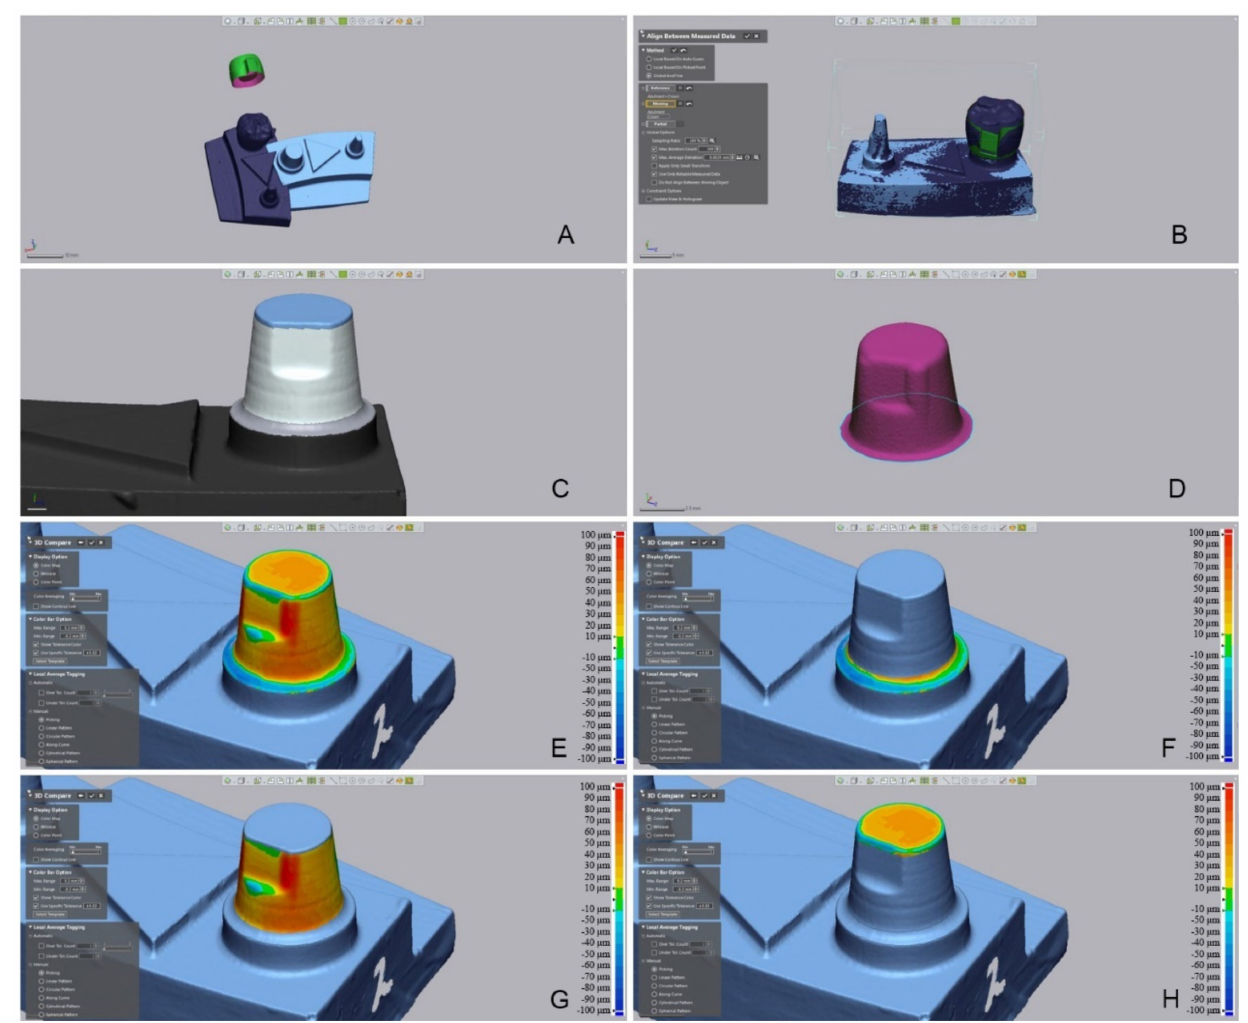
Figure 5. Marginal and internal fit measurement using triple-scan data. ( A ) Import of three scan files; ( B ) initial and best-fit alignment; ( C ) segmentation of the measurement region; ( D ) elimination of crown data beyond the margin; ( E ) measurement of overall internal space; (F) 3-dimensional comparison in the cervical section; ( G ) 3-dimensional comparison in the axial section; ( H ) 3-dimensional comparison in the occlusal